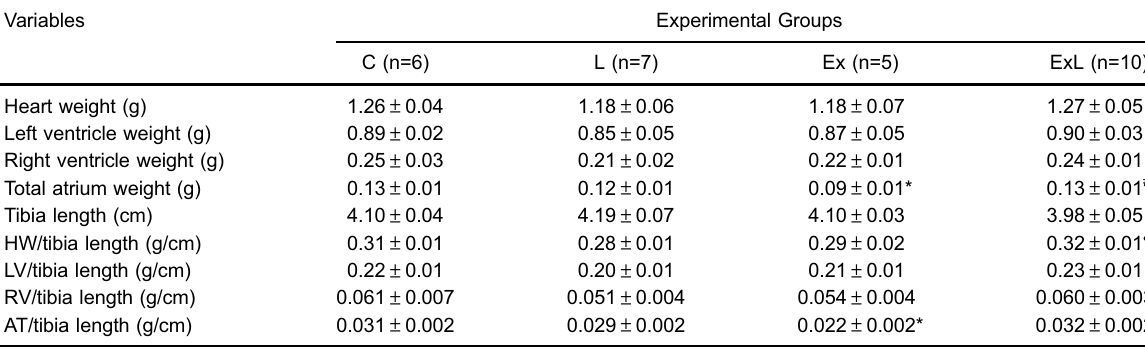
Table 3. Morphological characteristics.